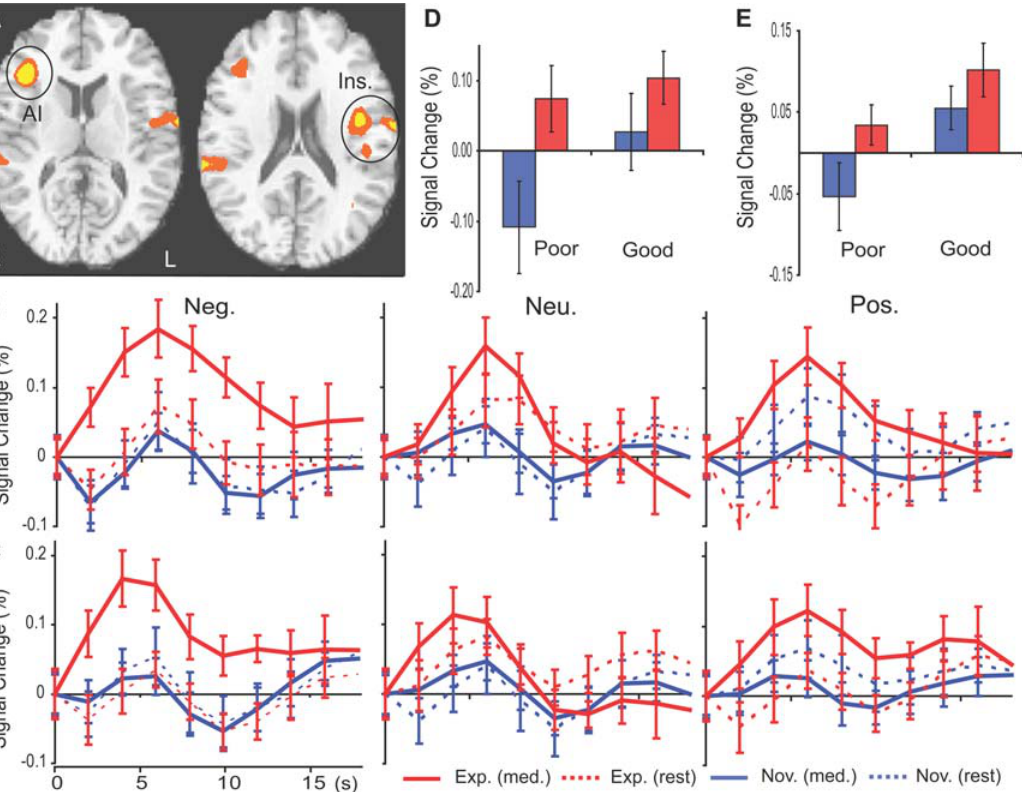
Figure 1. State by Group by valence Interaction: A. (AI) and (Ins.) stand for anterior insula and insula, respectively (z=12 and z=19, 15 experts and 15 novices, color codes: orange, p , 5.10ˆ-2, yellow, p , 2.10ˆ-2). B, C. Impulse response from rest to compassion in response to emotional sounds in AI ( B ) and Ins. ( C ). D–E. Responses in AI ( D ) and Ins. ( E ) during poor and good blocks of compassion, as verbally reported, for 12 experts (red) and 10 novices (blue).